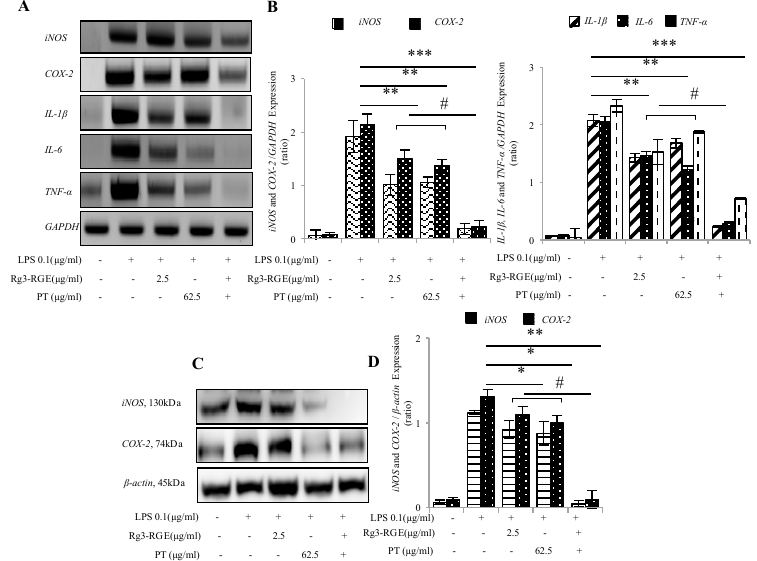
Figure 3. Rg3-RGE + PT hindered the expression of pro-inflammatory mediators and cytokines. RAW Figure 3. Rg3 ‐ RGE + PT hindered the expression of pro ‐ inflammatory mediators and cytokines. RAW 264.7 cells were pre-incubated with Rg3-RGE + PT for 30 min and then stimulated with LPS for 18 h. 264.7 cells were pre ‐ incubated with Rg3 ‐ RGE + PT for 30 min and then stimulated with LPS for 18 h. Total RNA and proteins from cells were extracted and the mRNA and protein expression of iNOS , COX-2 and IL-1 β , IL-6 and TNF- α determined by ( A , B ) RT-Polymerase Chain Reaction (PCR), and ( C , D ) Western blot. GAPDH (Glyceraldehyde 3-phosphate dehydrogenase) and β -actin were used as internal control. Images are representative of three independent experiments. Values in bar graphs represent mean ± SD of three independent experiments. *** p < 0.001, ** p < 0.05 and * p < 0.01 considered significant compared to LPS and # p < 0.01 compared to inhibition by only Rg3-RGE or PT. Triplicates for RT-PCR were completed within 10 days whereas Western blot analysis were completed within 3